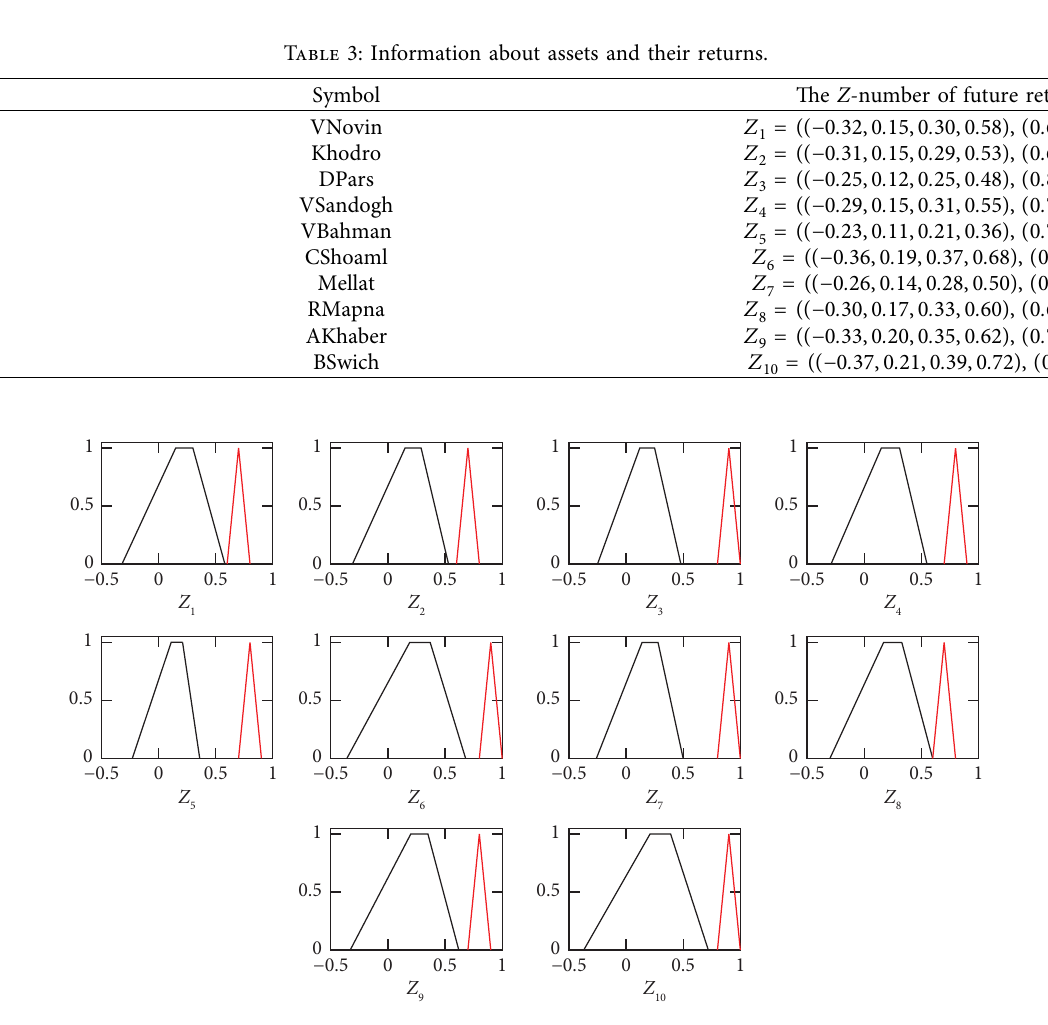
Figure 3: Te chart of factors return on assets of Tehran stock